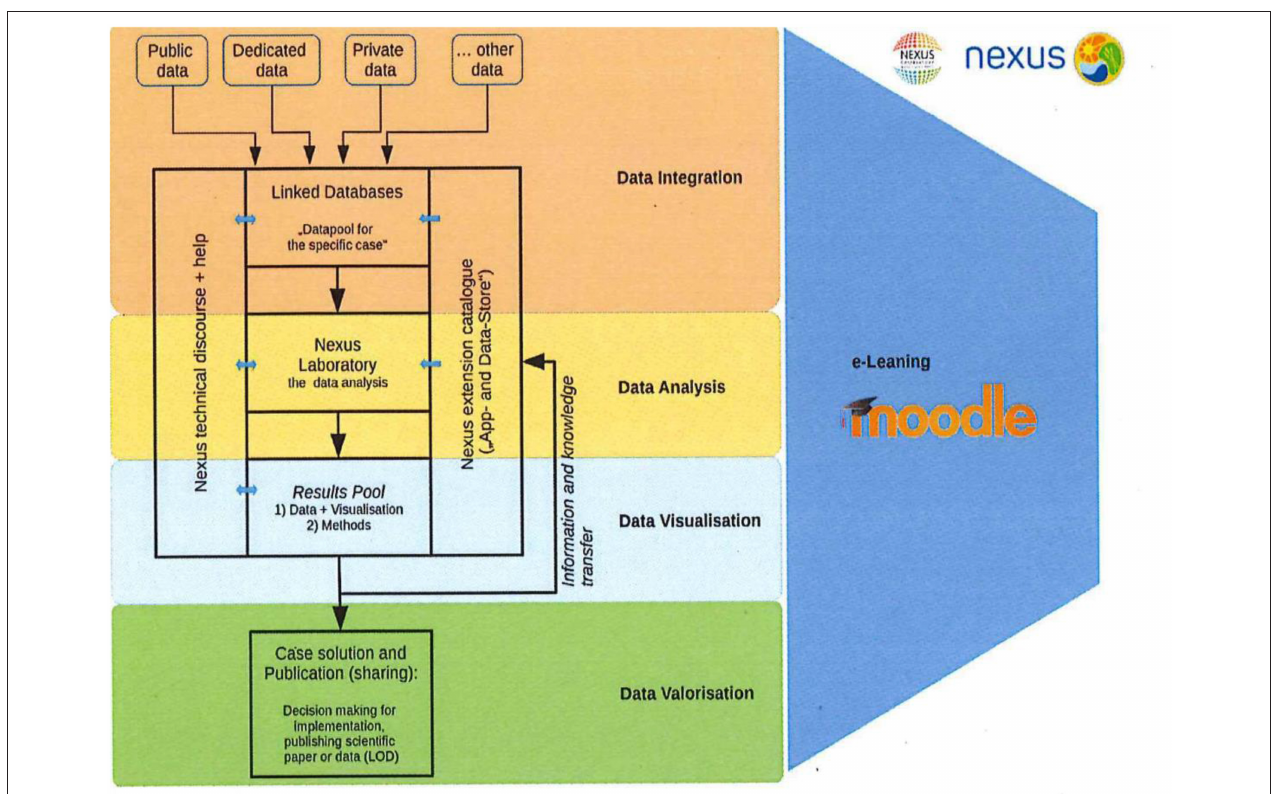
FIGURE 4 | A stylized computing workflow for an observatory. Adapted from Kurian et al.